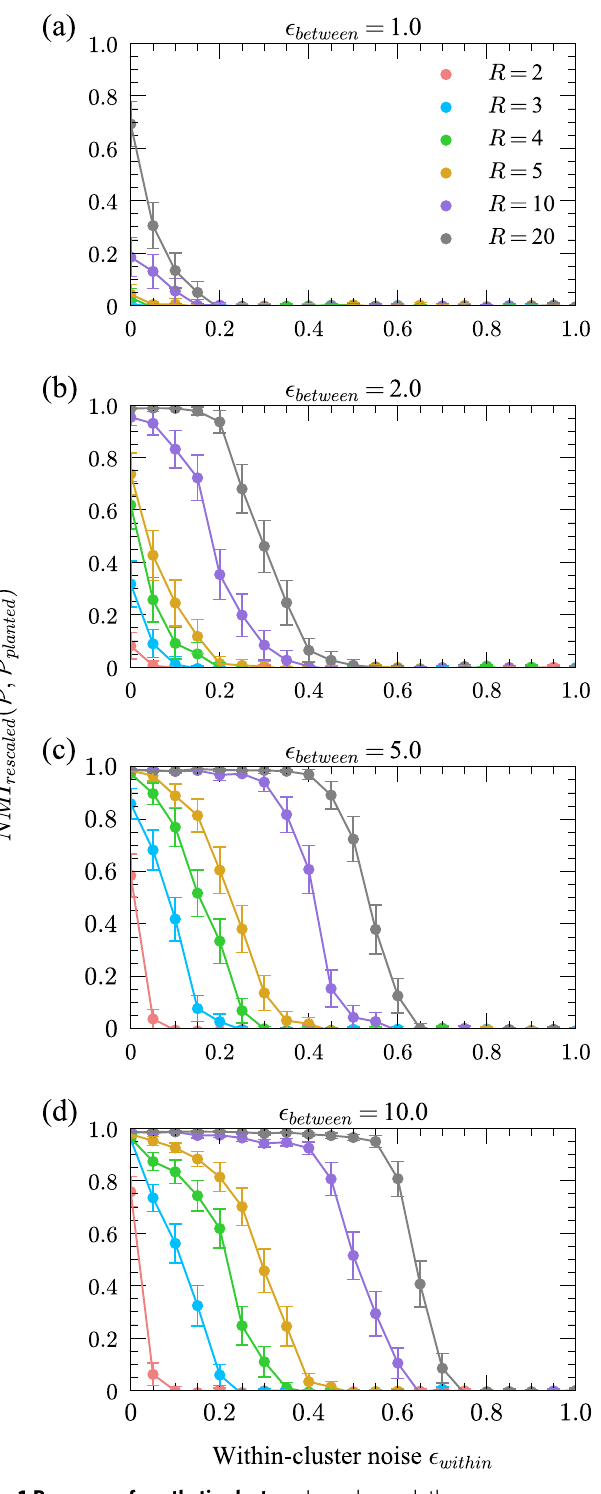
Fig. 1 Recovery of synthetic clusters. In each panel, the recovery performance of our algorithm, as measured by the rescaled normalized mutual information (NMI) of Eq. (5), is plotted on the y -axis against the level of within-cluster noise ϵ within on the x -axis, for between-cluster noise a ϵ between = 1.0, b ϵ between = 2.0, c ϵ between = 5.0, and d ϵ between = 10.0. The number of covariate categories R is varied within each the panel (denoted by different colors), and the number of clusters is set to K = 5. Error bars represent 2 standard errors in the